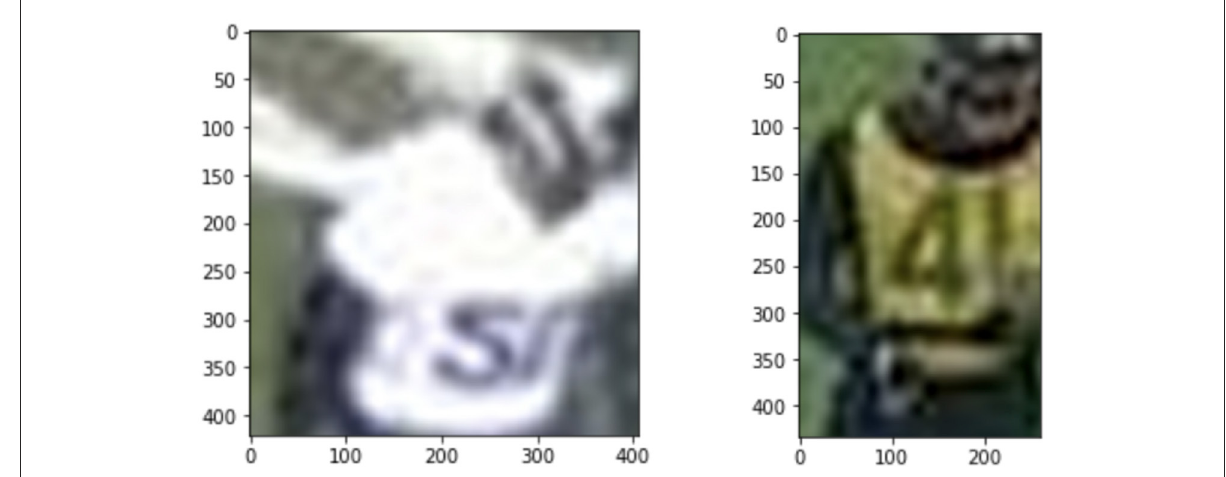
FIGURE8 Images where multi-label predicted class 100. The multi-label model is not sure of the number class when the input image has very low resolution.